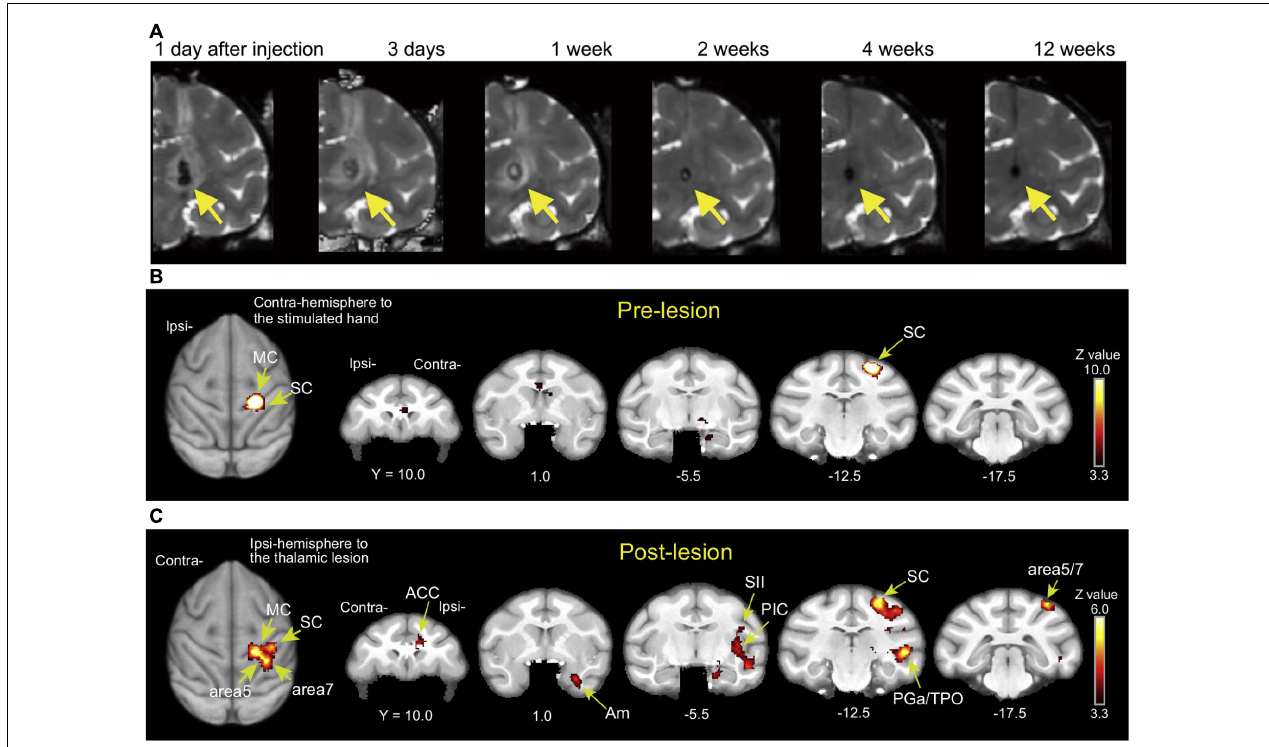
FIGURE 2 | (A) T2-weighted MRI showing the time course of hemorrhagic stroke after collagenase type IV induction (coronal images). A hematoma and edema were seen as the hypointense stroke core in the VPL of the thalamus (arrows) and the surrounding hyperintense rim. Reproduced from Figure 1 of the study by Nagasaka et al. (2017). (B,C) Brain activity changes associated with CPSP. Brain activity associated with mechanical stimulation to the hand contralateral to the lesioned hemisphere (or the corresponding hand before stroke) during the pre-lesion and post-lesion periods when CPSP was developed. ACC, anterior cingulate cortex; Am, amygdala; MC, primary motor cortex; PGa, anterior subdivisions of the angular gyrus; PIC, posterior insular cortex; SC, primary somatosensory cortex; SII, secondary somatosensory cortex; TPO, temporo-parieto-occipital junction. Reproduced from Figure 3 of the study by Nagasaka et al. (2020).